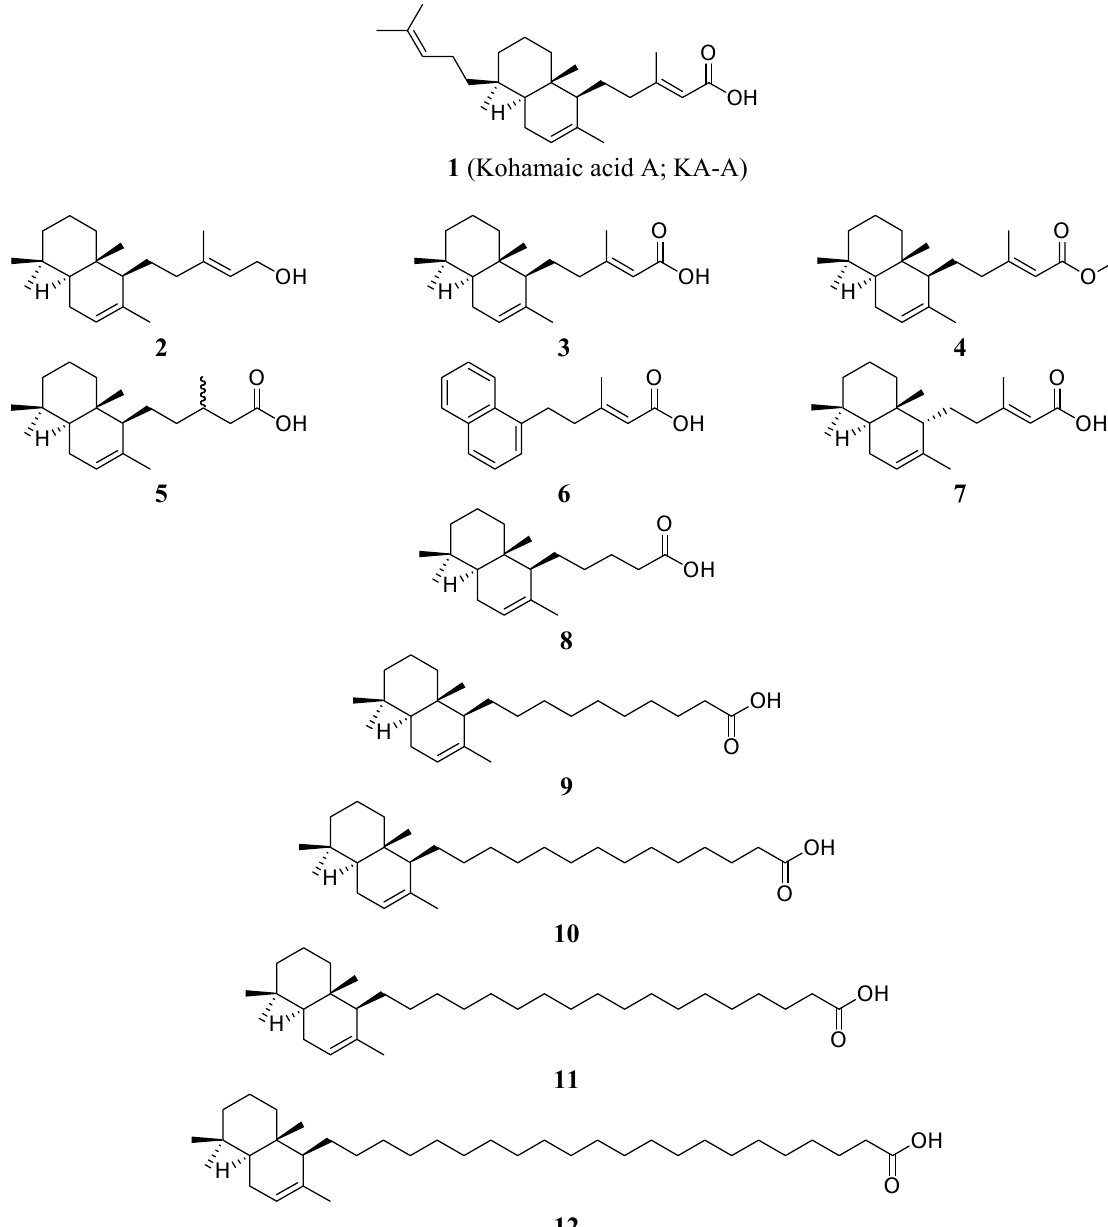
Figure 1. Structures of kohamaic acid A and its